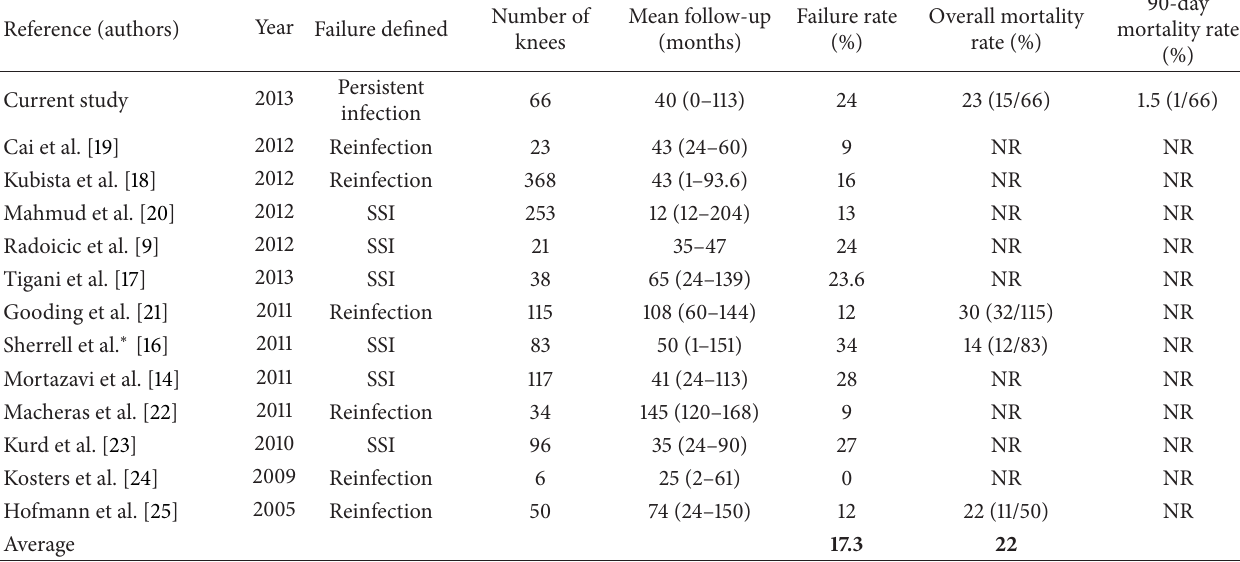
Table 6: Failure and mortality rates reported in prior studies for two-stage revision